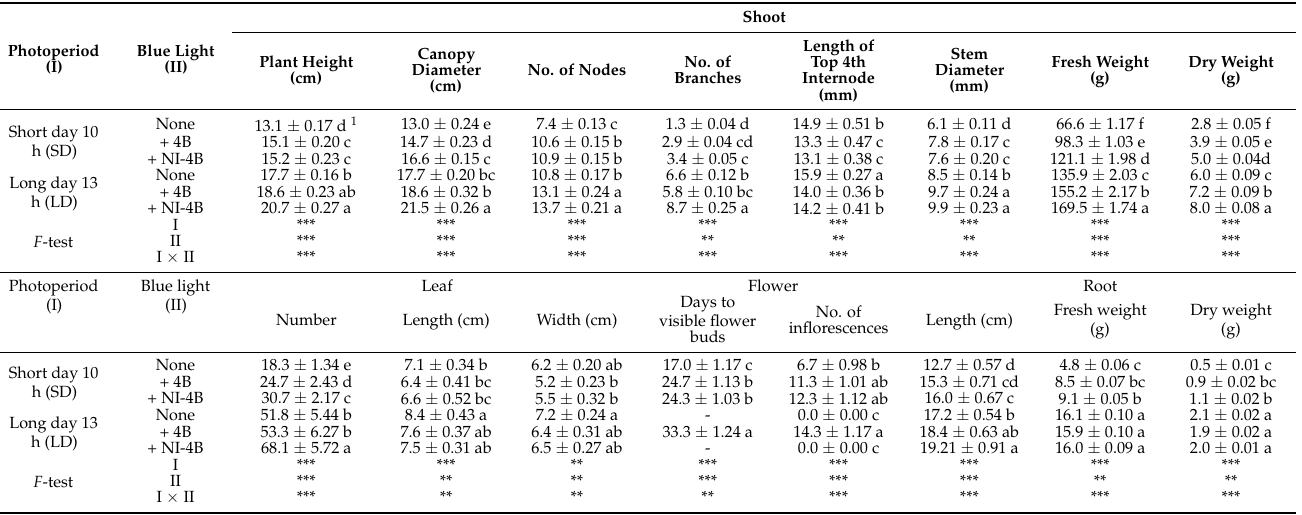
Table 2. The effects of the supplementary and night-interrupting 10 µ mol · m − 2 · s − 1 PPFD B light on the morphological characteristics of kalanchoe ( Kalanchoe blossfeldiana ‘Rudak’) after 60 days of exposure to the photoperiodic light treatments.